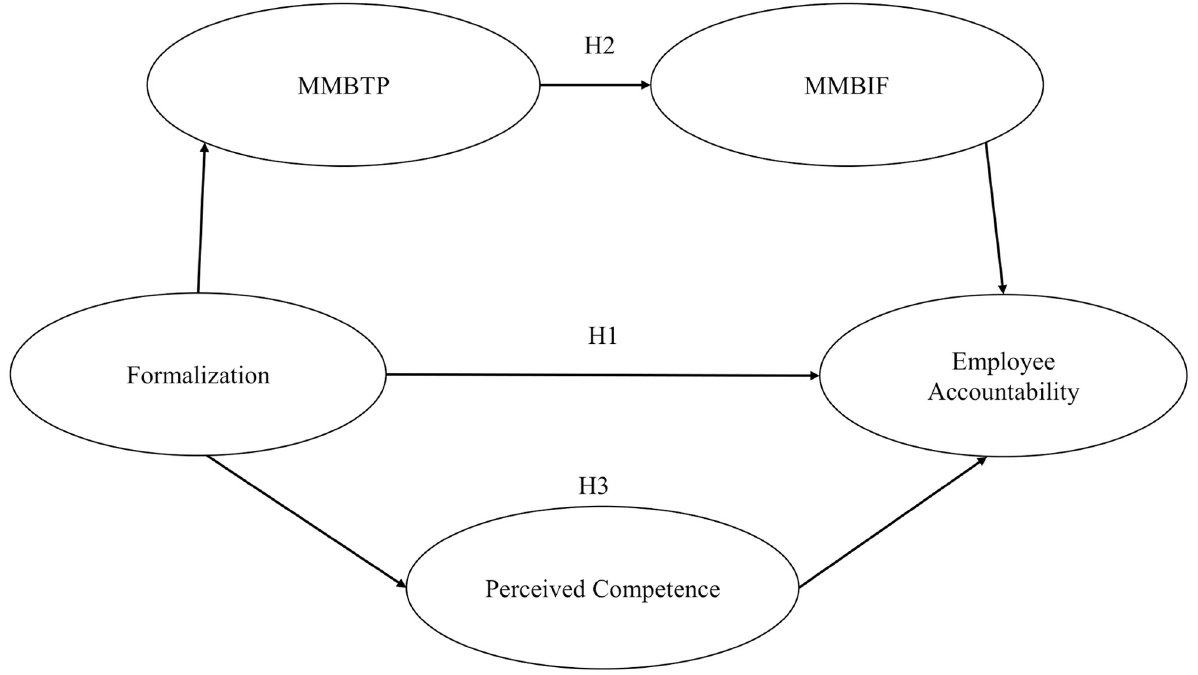
Fig 1. The research model of the study. MMBTP = Managerial monitoring behavior for task performance; MMBIF = Managerial monitoring behavior for interpersonal